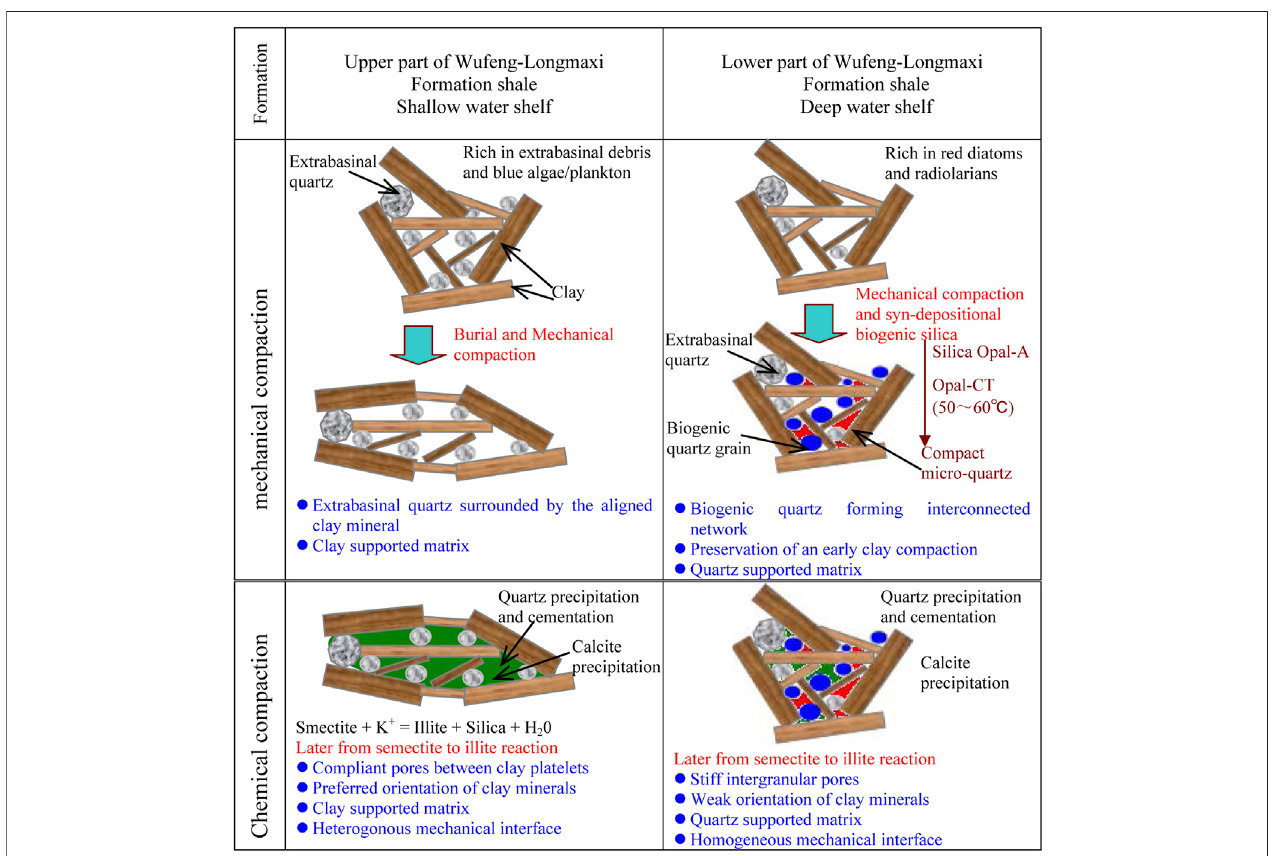
FIGURE 14 | Conceptual model summarizing the depositional and diagenetic processes of the Wufeng-Longmaxi Formation shale.